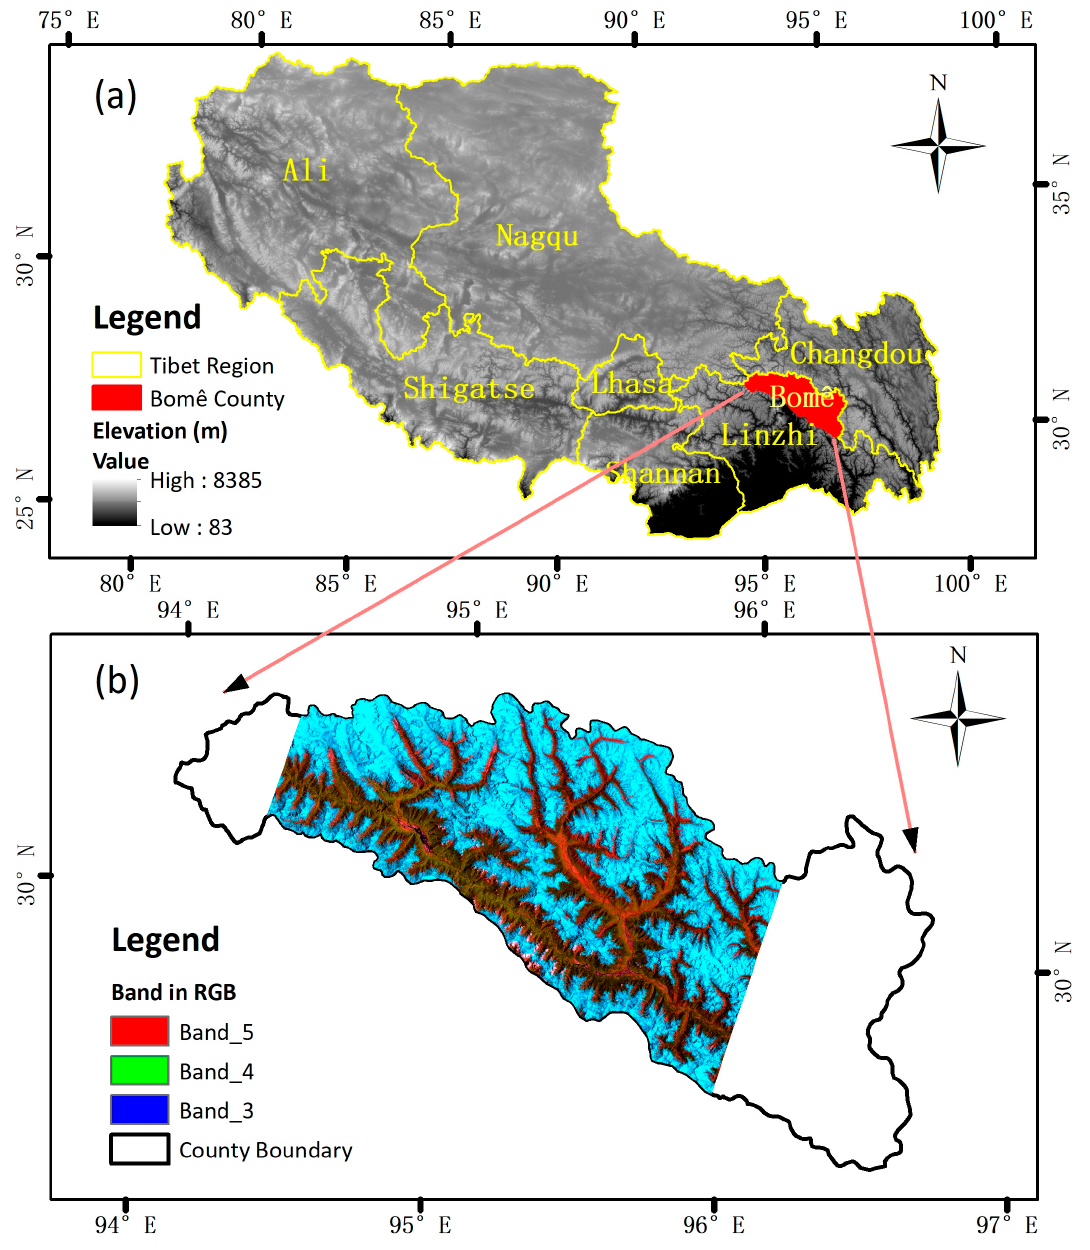
Figure 1. Study area: ( a ) Tibet, China; ( b ) Study area. Standard false colour composite image from Landsat-5, 17 May 1990.